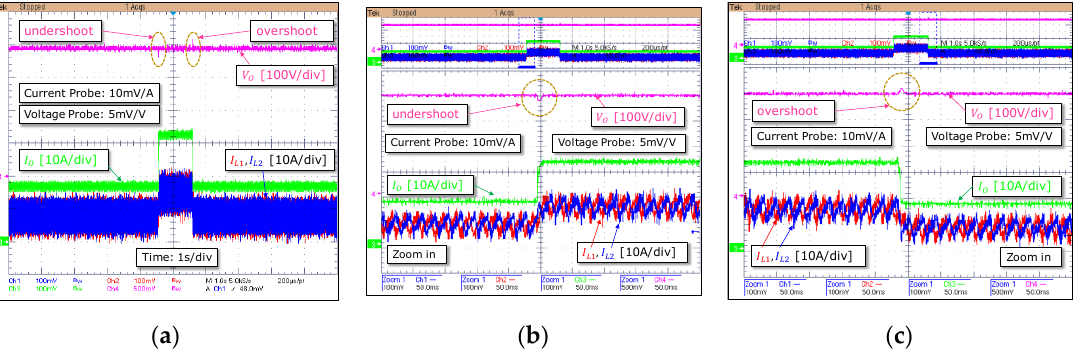
Figure 20. Experimental waveforms for optimized controllers at V in = 250 V, V O = 385 V, R O = 25 Ω/12.5 Ω, ( a ) overview when 100% load change, ( b ) zoom-in waveforms for positive load change, ( c ) zoom-in waveforms for negative load change.